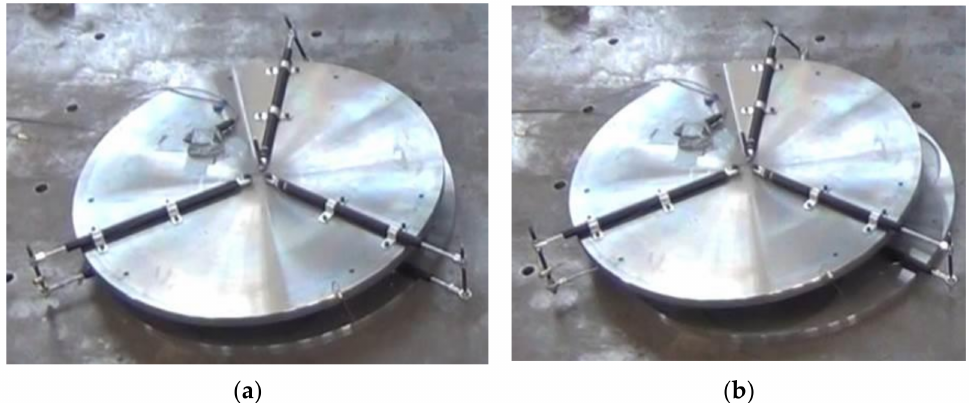
Figure 19. Maximum displacement response of the same device under 311 ground motion with